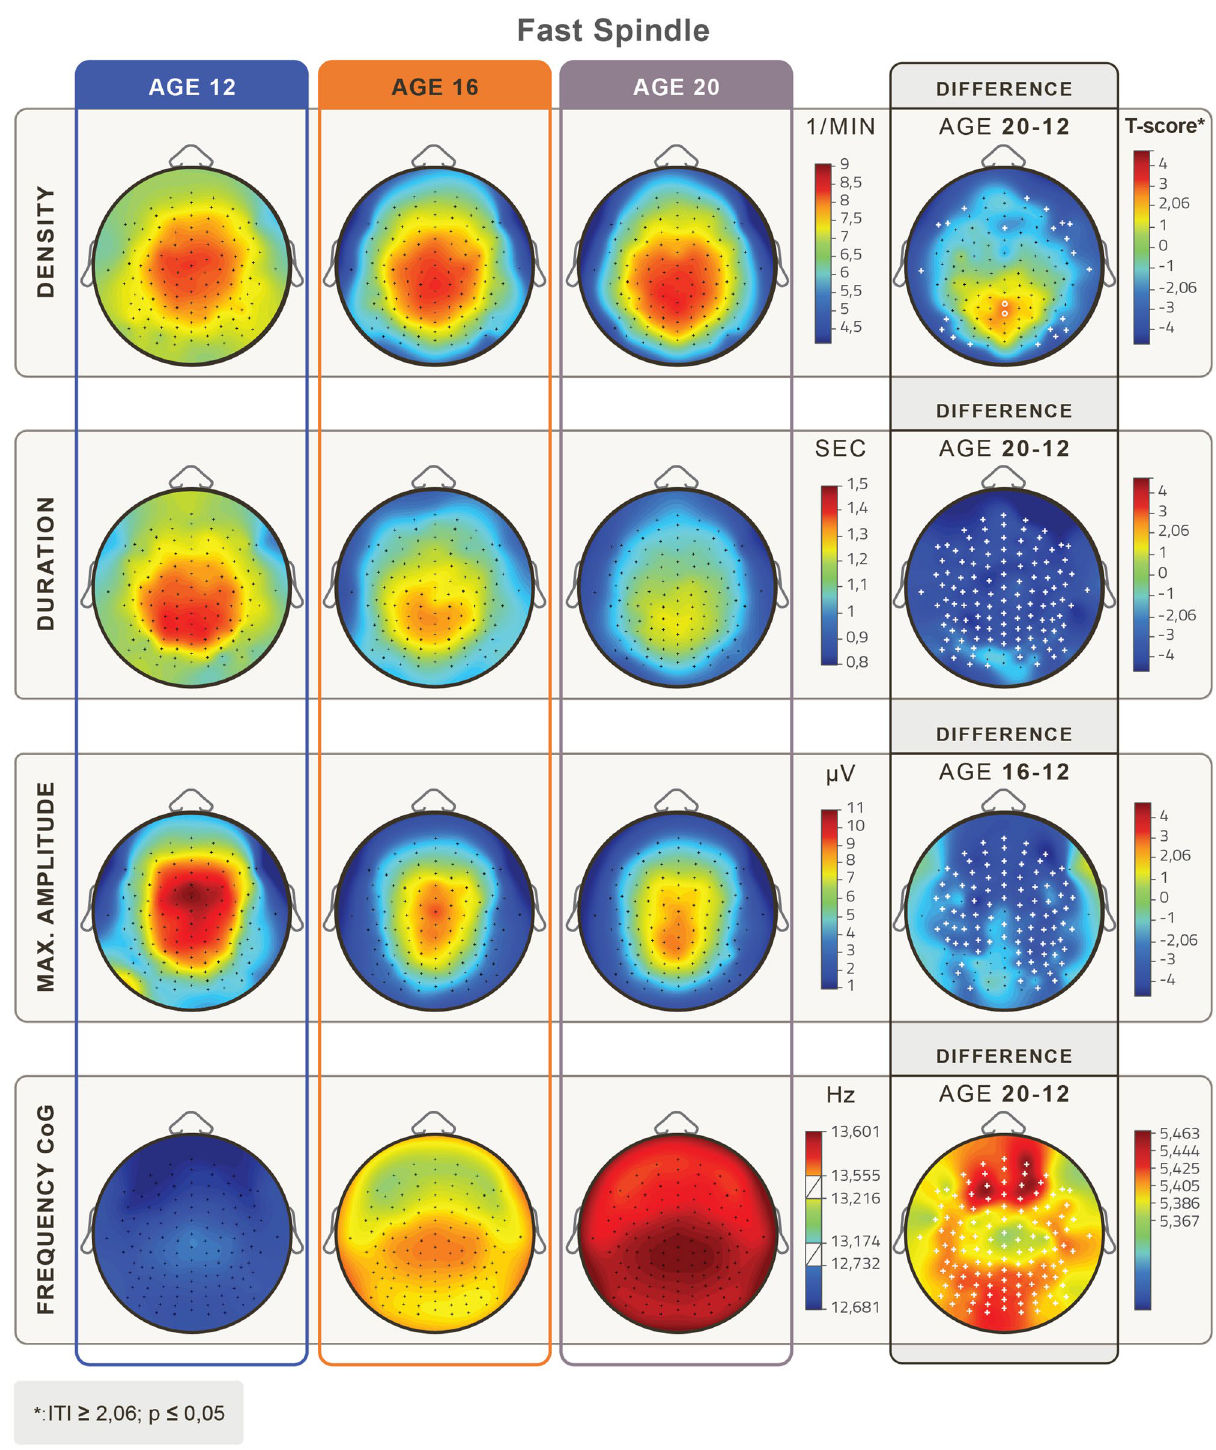
Figure 2. Topographical distribution of mean fast sleep spindle parameters in the age groups of 12, 16 and 20 years of age. Rows depict age-related changes in fast sleep spindle density (1/min), duration (s), maximum amplitude (µV), and frequency based on the center of gravity (CoG) (Hz). Relevant age-group differences are depicted in the 4th column. White crosses depict Rüger area significant differences, and white circles depict significant but not Rüger area significant differences. Fast spindle density increased significantly, but not Rüger significantly centro-parietally between 12 and 20 years of age, and Rüger significantly decreased at the perimeter of the scalp. There was a significant overall decrease in duration and a frontal decrease in maximum amplitude. Frequency significantly increased at all derivations with frontocentral maxima from the younger to the older age group. (Level of significance: p < .05, T-score values are matched with the colorbar, T ≥ │ 2.06 │ p < 0.05, at T ≥ │ 2.787 │ p < 0.01 and at T ≥ │ 3.725 │ p <